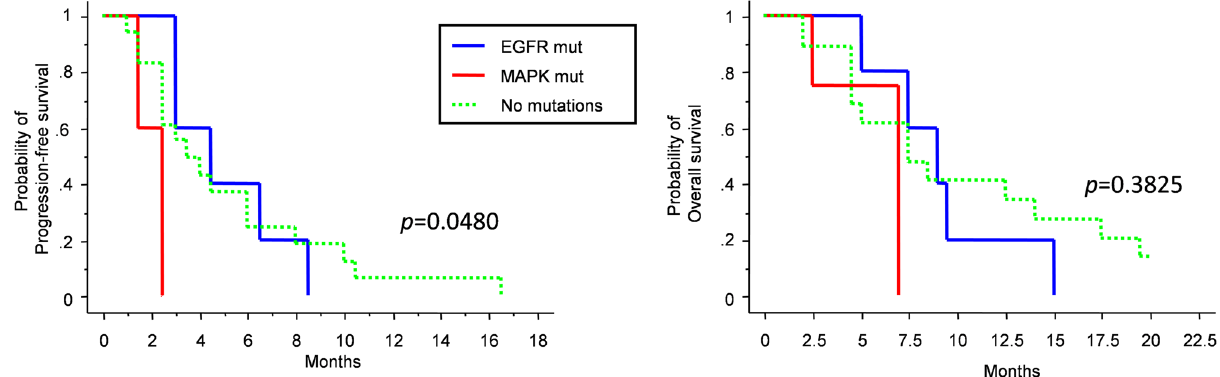
Figure 1. Kaplan–Meier survival curves for PFS (left) and OS (right) depending on pathway mutation at next- generation sequencing analysis. Covariate Hazard ratio Confidence interval p- value